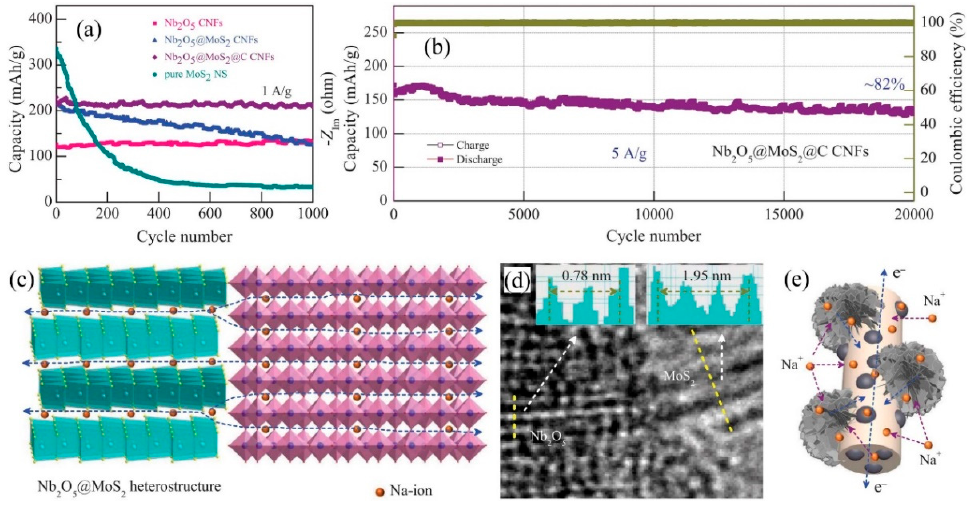
Figure 9. ( a ) Cycling stability of samples at a current density of 1 A g − 1 . ( b ) Cycling stability of Nb 2 O 5 @MoS 2 @C CNFs electrode at a high current density of 5 A g − 1 . ( c ) One kind of the heterointerface of Nb 2 O 5 @MoS 2 with ( d ) the corresponding TEM image. ( e ) The possible sodium storage mechanism. Reproduced with permission from Ref. [93] Copyright 2020 Wiley. Table 2. Energy storage performances of the reported Nb 2 O 5 -based and other typical intercalation- type anode materials for application in SIBs.